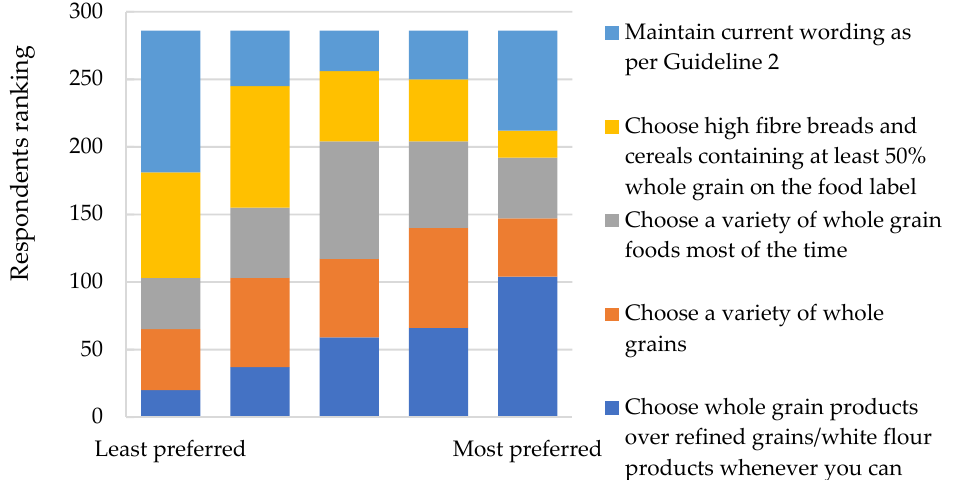
Figure 2. Ranking of preferred new guideline statements for the promotion of whole grain foods ( n = 286) .